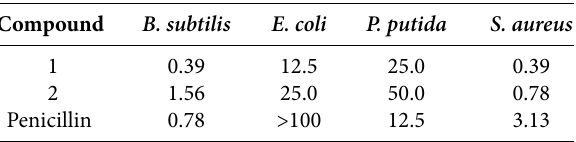
Table 4. MIC (μg mL –1 ) values of the antibacterial activity of the complexes